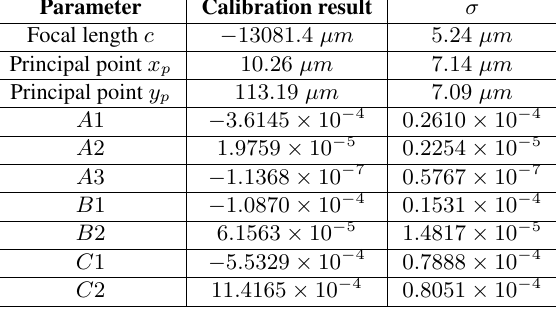
Table 1: Calibration of FLIR Tau 640 thermal camera.